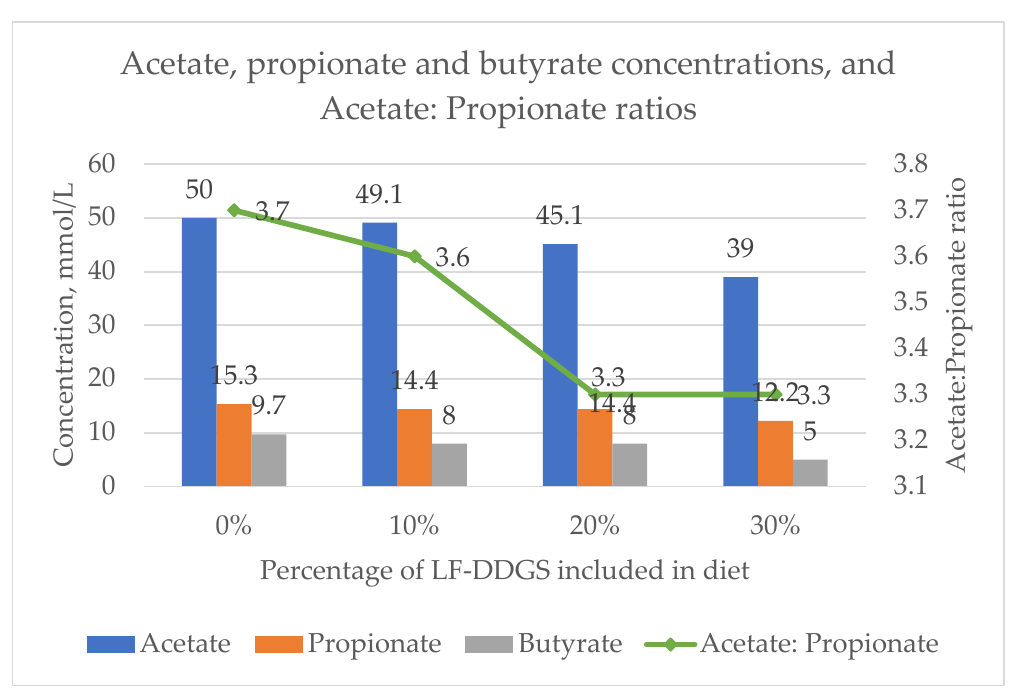
Figure 1. Acetate, propionate, and butyrate concentrations and the acetate:propionate ratio of castrated male goats fed with different levels of low-fat distillers dried grains with solubles (LF- DDGS) for 84 days.